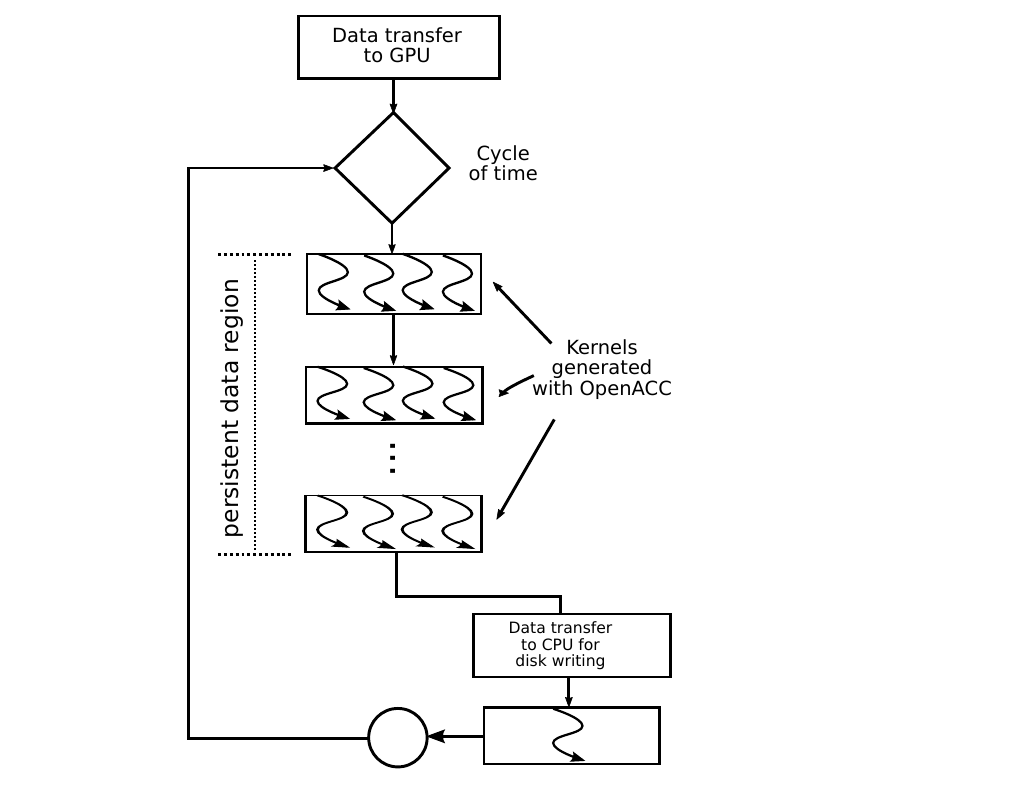
Figure 5. Flux diagram of design in OpenACC maintaining persistent data regions between